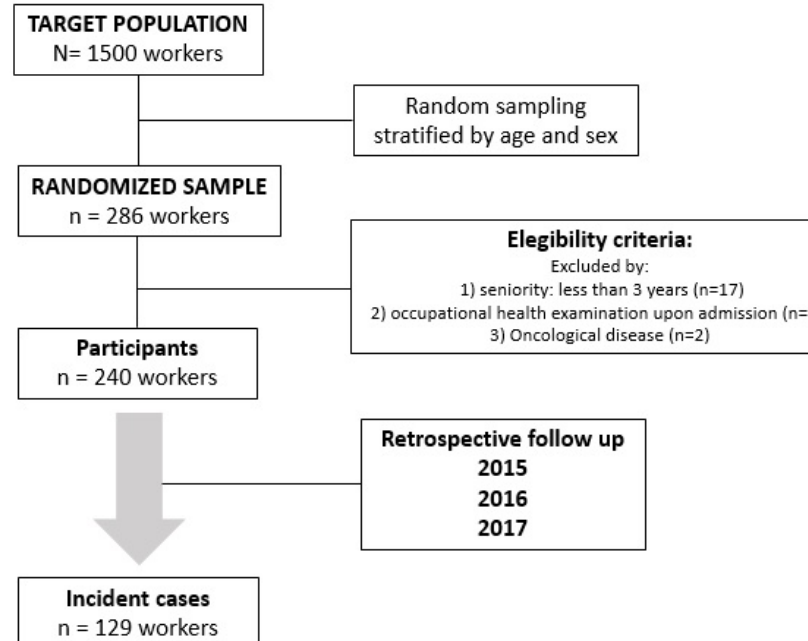
Figure 1. Flowchart of study participants.